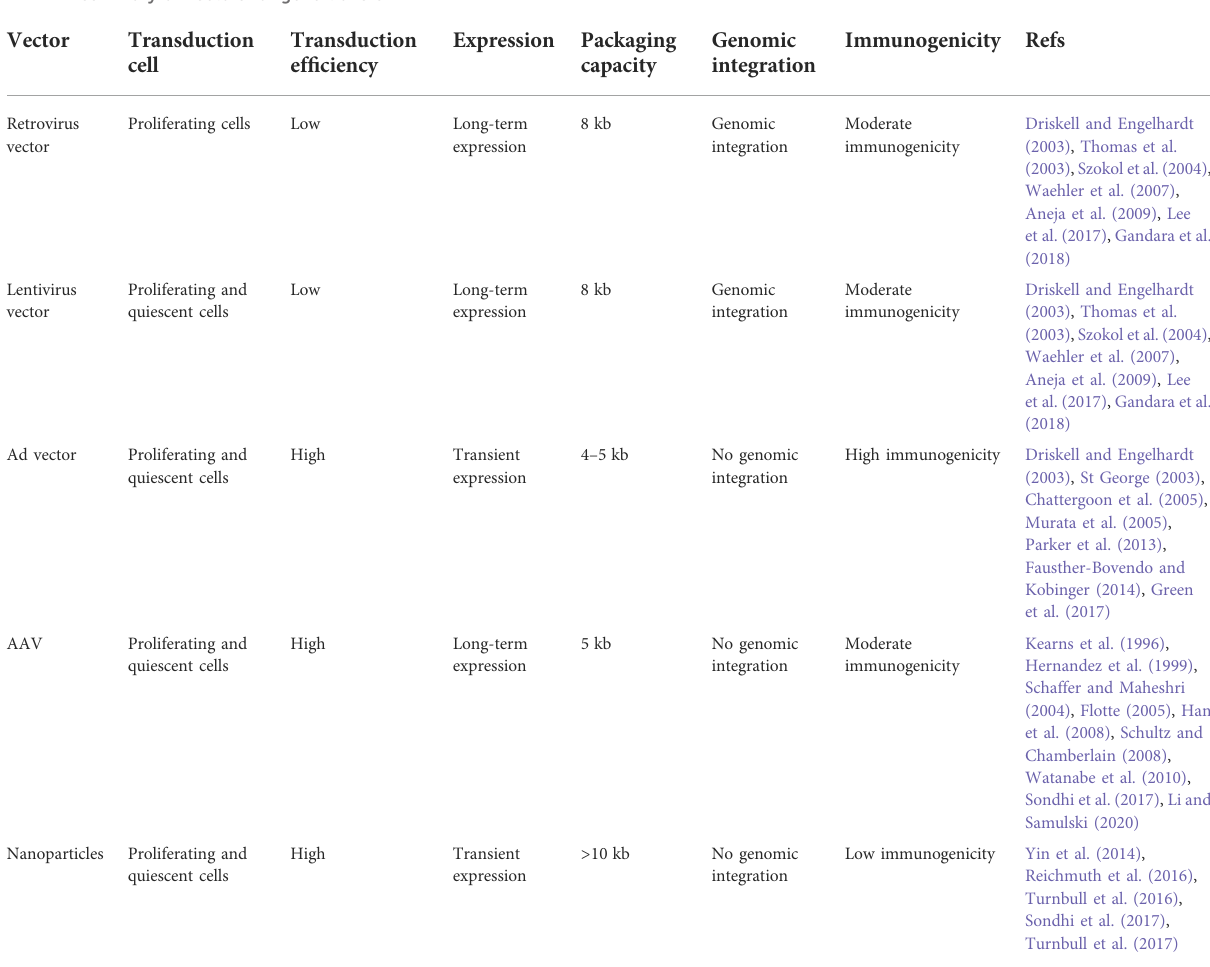
TABLE 2 Summary of vectors for gene